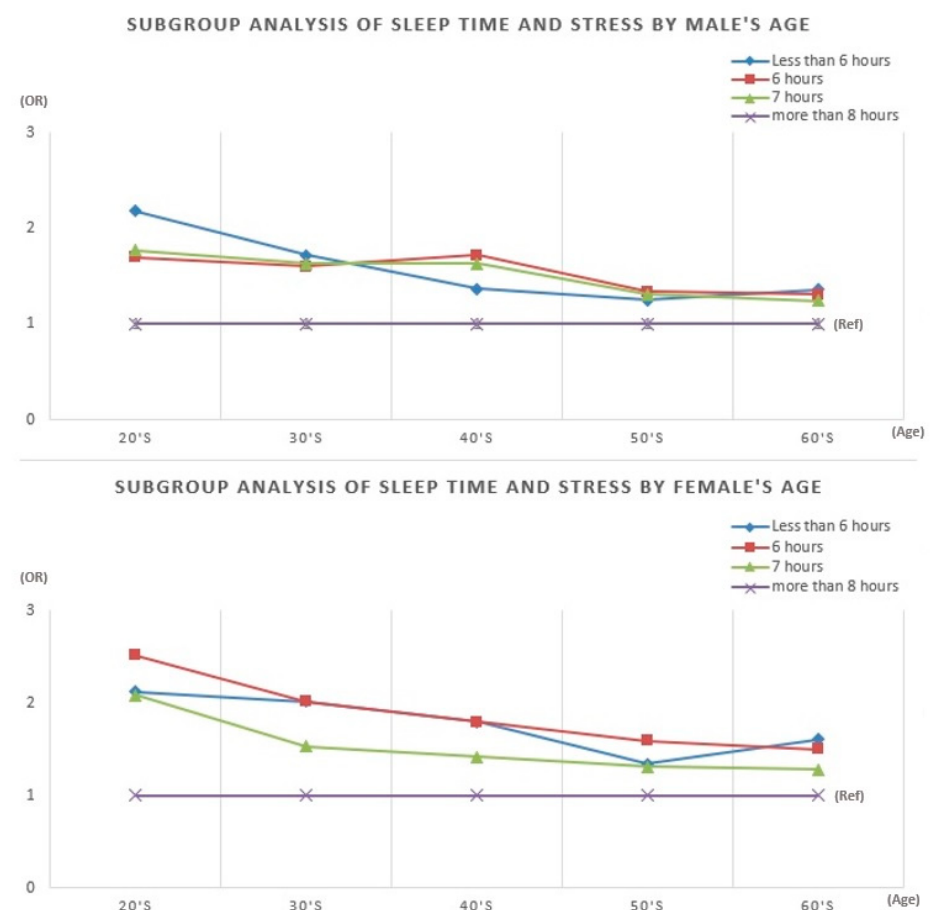
Figure 1. Subgroup analysis of sleep time and stress by age